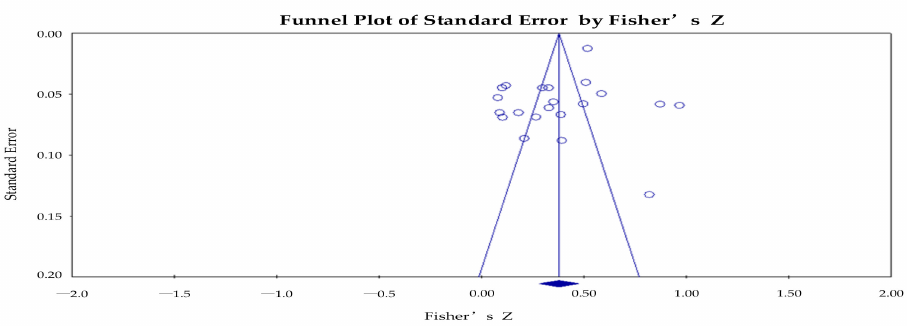
Figure 5. Total sample funnel chart.